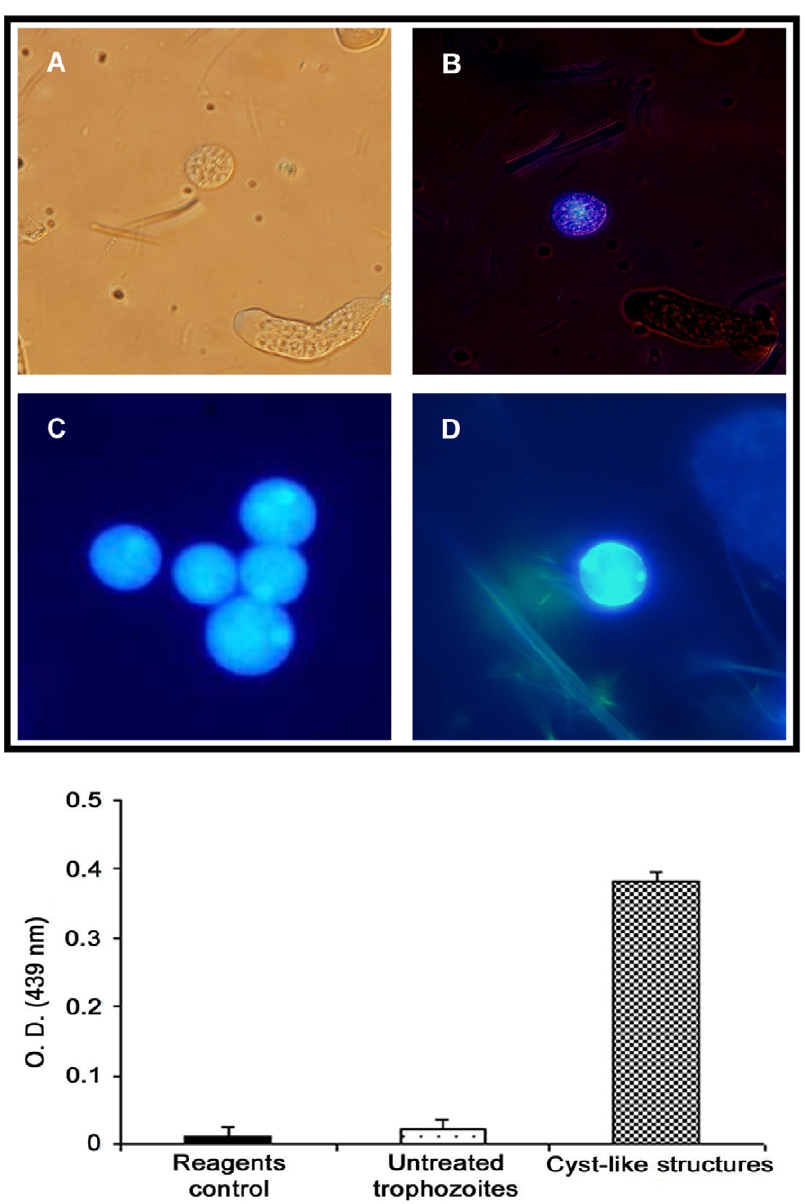
Figure 2. Detection of chitin in E.histolytica CLS resistant to detergents by calcofluor white staining (upper panel) and a WGA- binding assay (bottom graphic). (A and B) Light and UV microscopy, respectively, of a mix culture of untreated trophozoites and CLS stained with calcofluor white. CLS is clearly differentiated from trophozoites by the spherical shape and small size. In B, blue fluorescence of CLS under UV contrasts with the absence of fluorescence in the trophozoites 20X; (C and D) Comparison of calcofluor staining of CLS (C) against an E. histolytica cyst isolated from human feces (D). In spite of both showing a similar blue-whitish fluorescence, staining of the surface is clearer in the cyst from human feces, whereas staining of some apparently internal structures (arrowheads), probably transporting vacuoles, is evident in the CLS (40X). In the bottom graphic, bars represent the standard deviations.